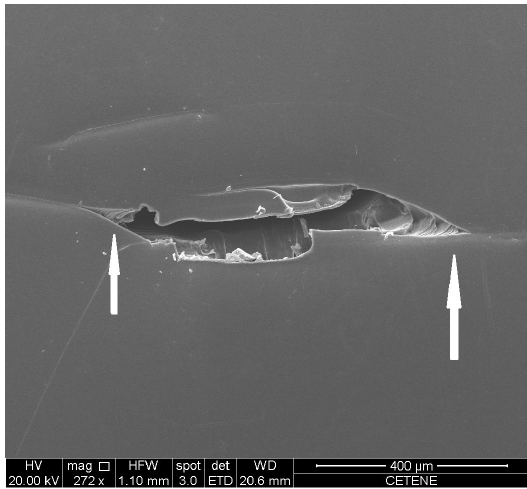
Figure 2. SEM image of a crack and crazes (pointed by arrows) in the PC surface after tensile strength test under methanol exposure.